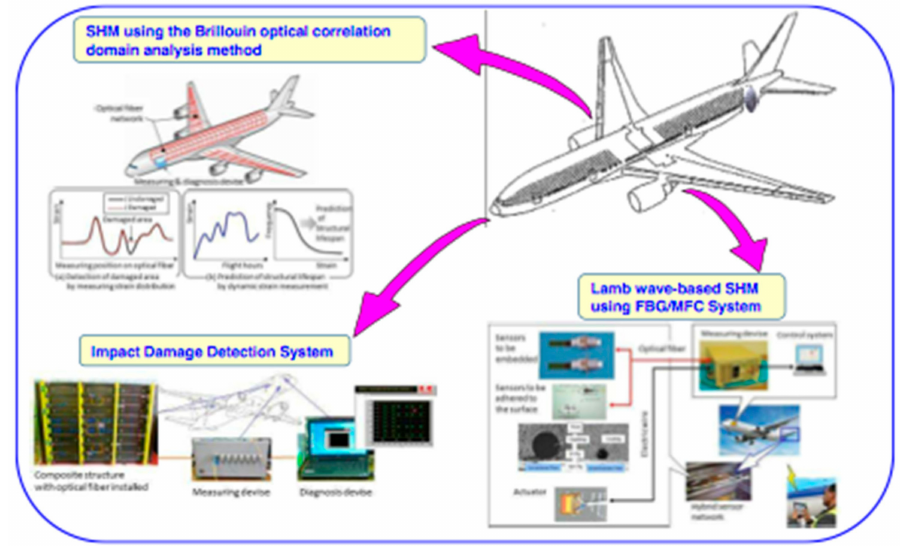
Figure 6. Damage detection alternatives with fiber optic sensors (reproduced with permission from [57]). Legend: Fiber Bragg Grating (FBG), Macro Fiber Composite (MFC).